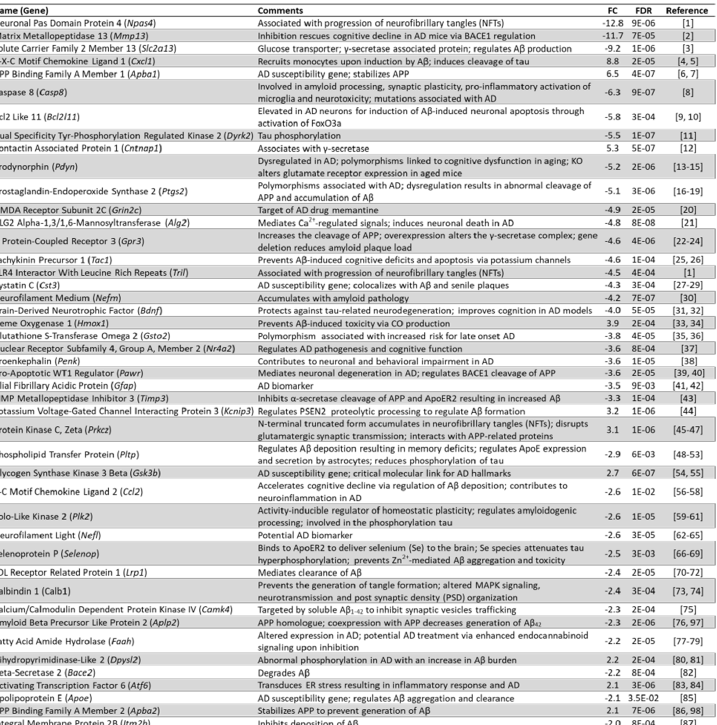
Figure 14. Alzheimer’s genes regulated by Arc. BACE1: β -secretase 1; APP: amyloid precursor protein; FoxO3a: forkhead box O3; ApoER2: apolipoprotein E receptor 2; PSEN2: presenilin 2; MAPK: mitogen-activated protein kinase; ER: endoplasmic reticulum. References: 1 [88], 2 [91], 3 [98], 4–5 [100,101], 6–7 [142,215], 8 [216], 9–10 [217,218], 11 [219], 12 [220], 13–15 [221–223], 16–19